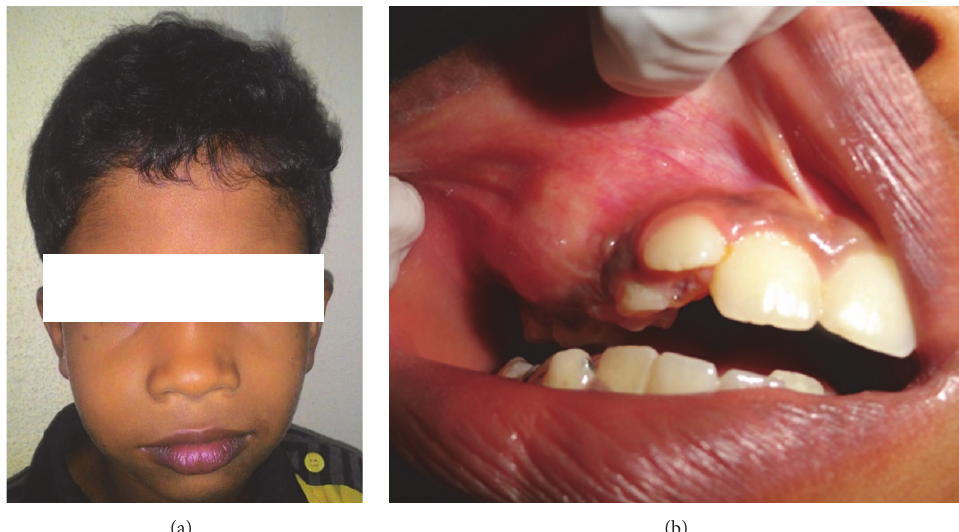
Figure 1: (a) Showing extraoral swelling in relation to the right side and (b) showing the extent of the intraoral ovoid swelling.